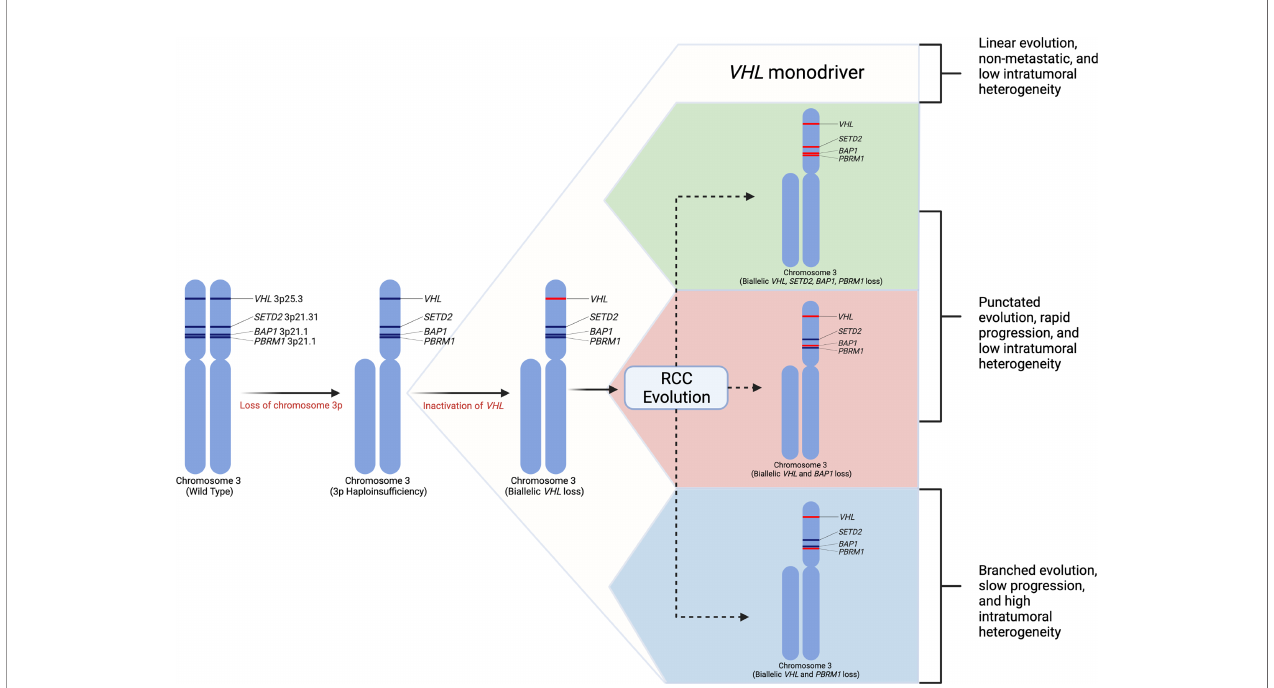
FIGURE 1 | Renal cell carcinoma genetic evolution. This model of renal cell carcinoma evolution demonstrates chromosome 3p loss as the initial “ fi rst-hit ” event. Subsequent biallelic loss of VHL occurs as a second hit. Tumor cells then may undergo multiple different pathways or “ branches ” of evolution based on mutations in other driver genes such as SETD2, PBRM1 , and BAP1 . These distinct evolutionary branches create different tumor phenotypes